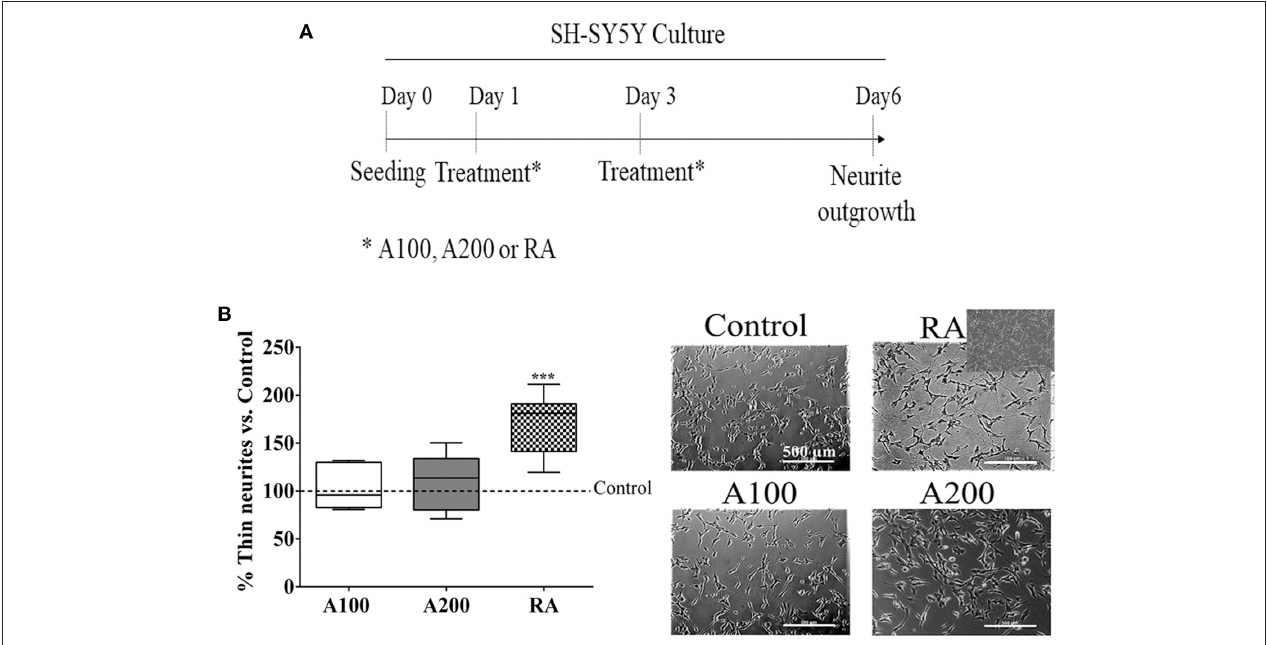
FIGURE 3 | SH-SY5Y neurite differentiation: (A) timeline of the experimental procedure. (B) Box plots and representative images showing axonal/neurite outgrowth in the presence of Retinoic Acid (RA) as expected, but not with angiogenin stimulation; n = 5–6. The insert in RA shows a micrograph representative of the WimNeuron analysis. Box plots represent median (IQR) of the percentage vs. control values of each independent experiment, *** p < 0.001 vs.